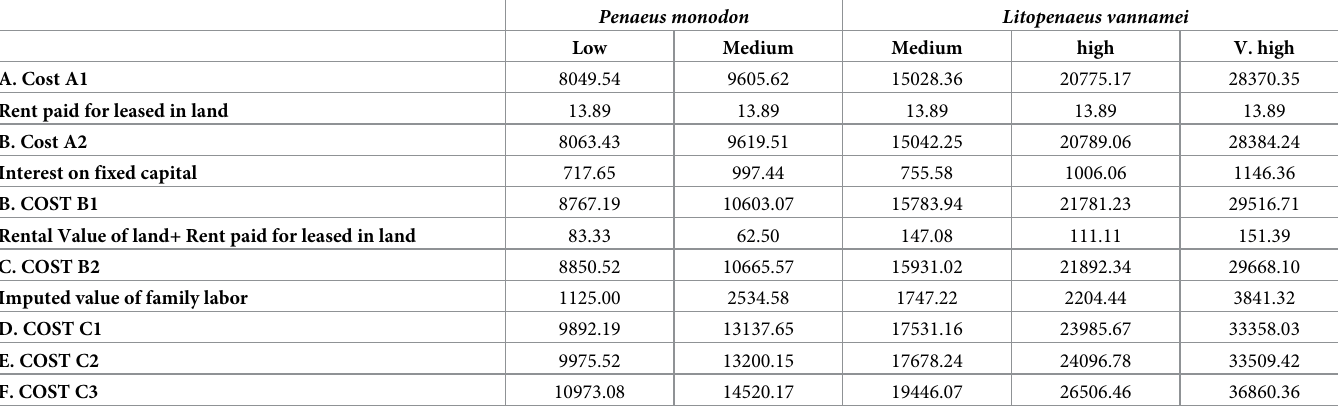
Table 5. Cost concept wise cost of production of shrimps (US$/ha).